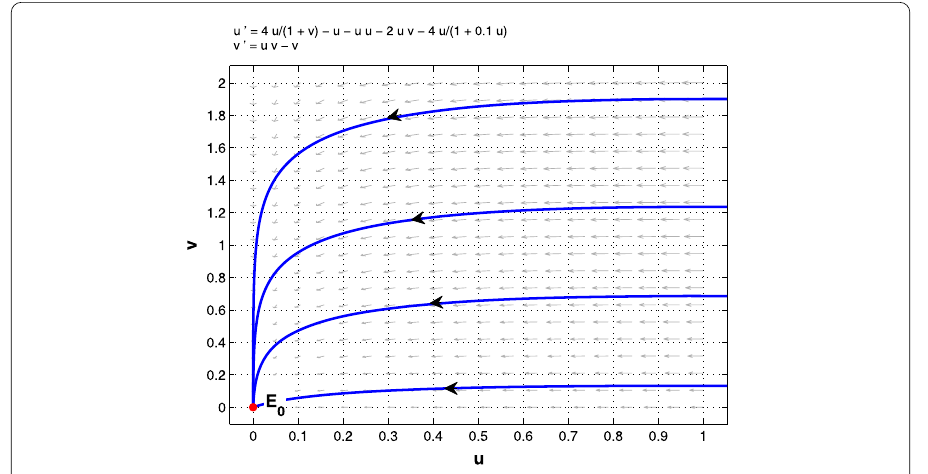
Figure 4 Dynamic behavior of system (5.1) with r 0 = 4, d = 1, k = a = m = 1, c = 0.5, p = 2, m 1 = 1, m 2 = 0.1, q = 4, and E =